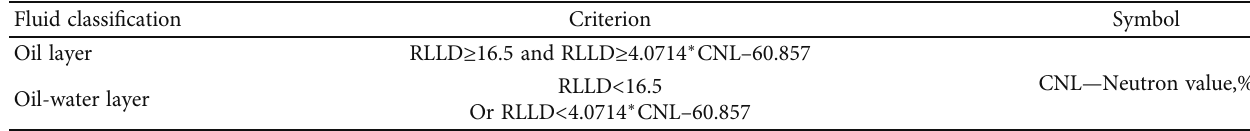
Table 6: Discrimination standard table.